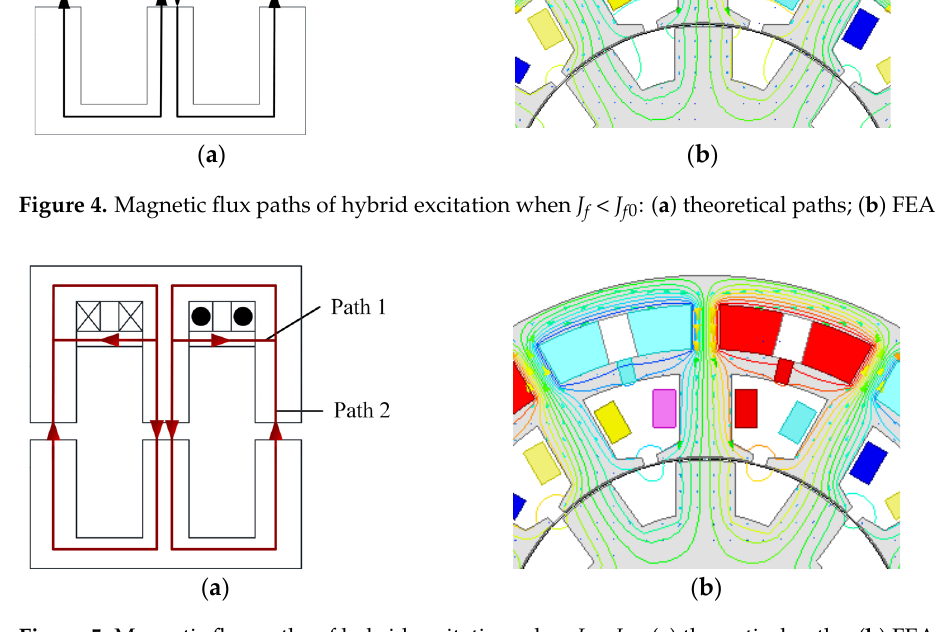
( b ) Figure 4. Magnetic flux paths of hybrid excitation when J f < J f 0 : ( a ) theoretical paths; ( b ) FEA paths. ( a ) ( b ) Figure 5. Magnetic flux paths of hybrid excitation when J f > J f 0 : ( a ) theoretical paths; ( b ) FEA paths.